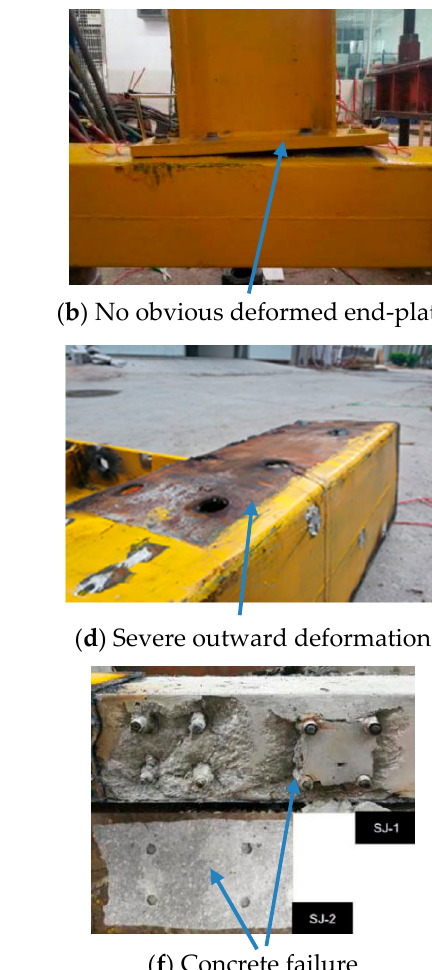
Figure 7. Failure mode I. ( a ) SJ-1; ( b ) SJ-2; ( c ) welding fracture in specimen SJ-1; ( d ) column wall in specimen SJ-1; ( e ) column wall in specimen SJ-2; ( f ) core